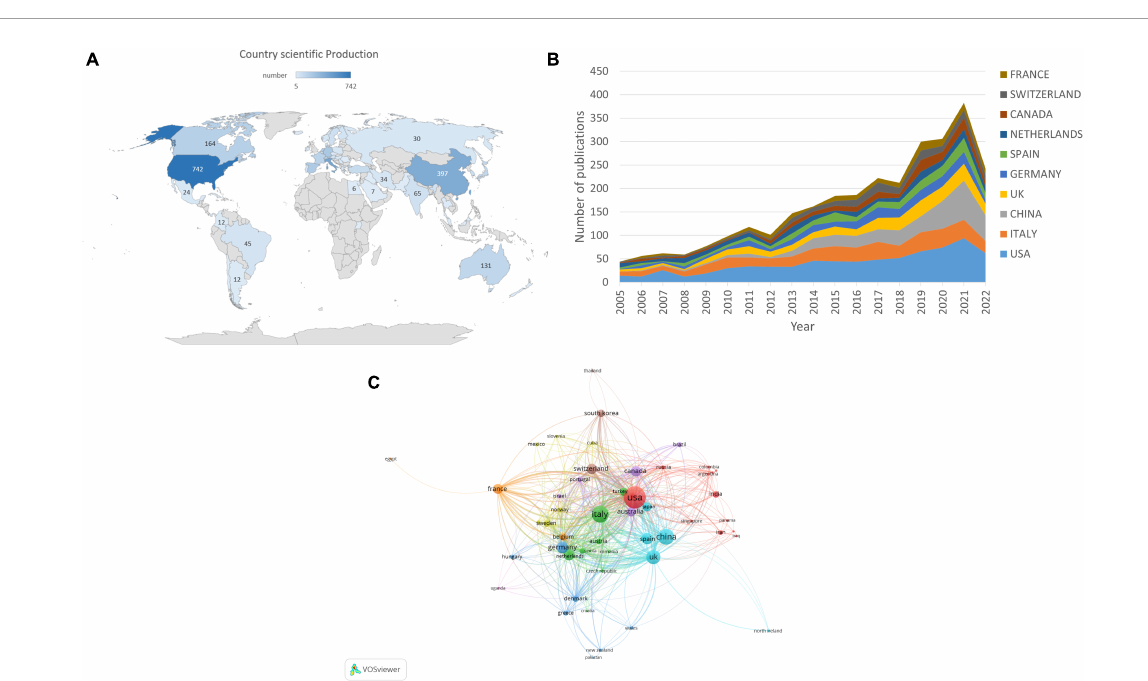
FIGURE3 Co-authorship analysis of countries/regions in EEG research for MCI. (A) Geographic distribution map displaying the global distribution of EEG for MCI. (B) The annual number of publications from the top 10 countries/regions between 2005 and 2022. (C) Citation map of countries/regions generated by the VOSviewer. The size of the node denotes the number of publications, the line shows the collaboration, and the color represents the various